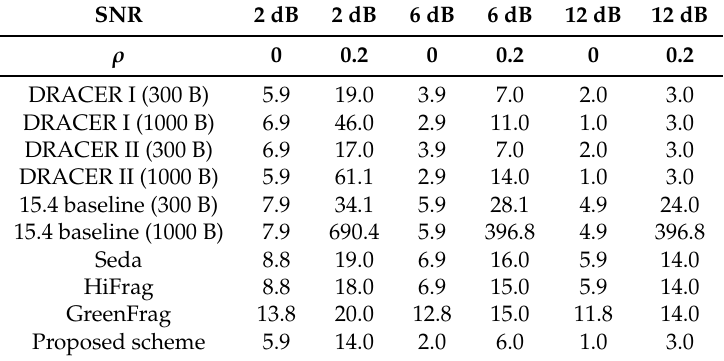
Table 2. Transmission delay according to the SNR when ρ = 0 and 0.2 (unit: s). DRACER, dynamic rate adaptation and control for energy reduction; HiFrag, hybrid frame fragmentation scheme.